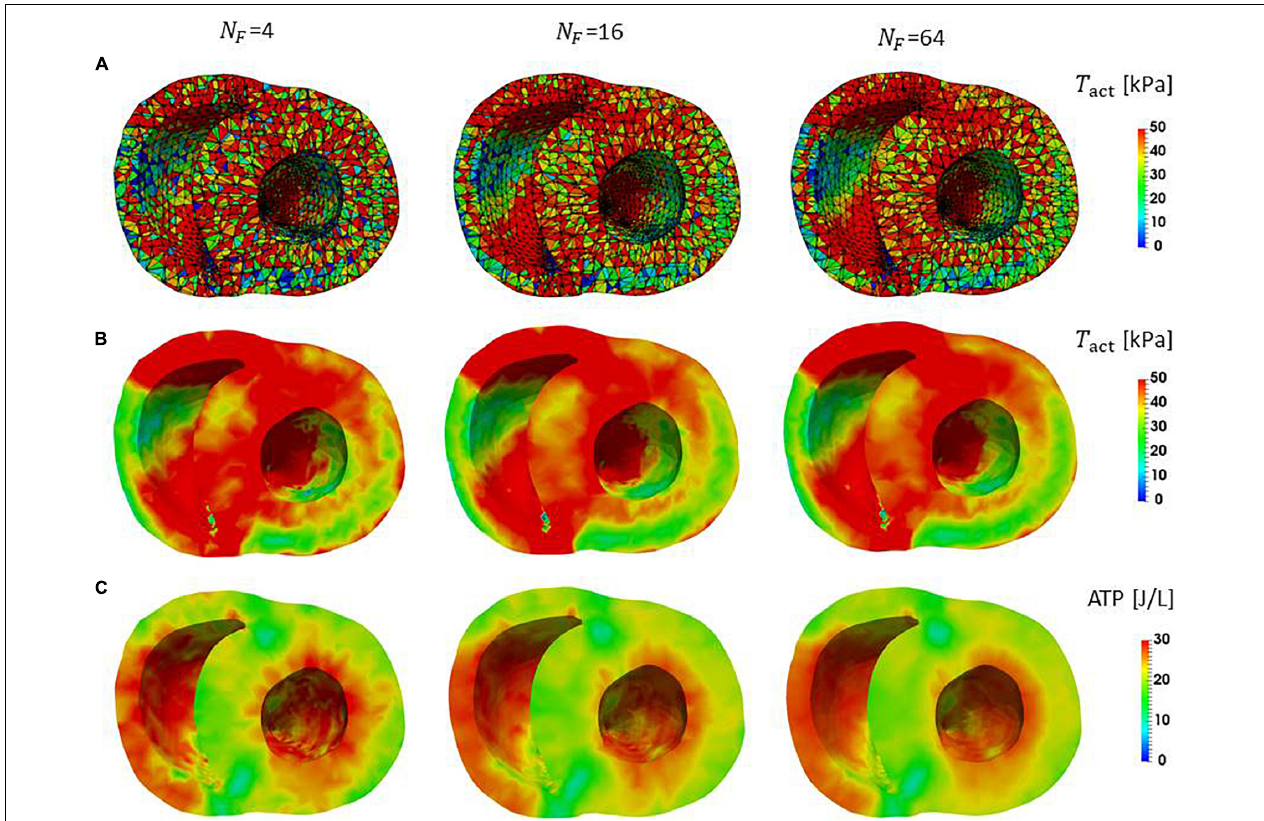
FIGURE 7 | Distributions of active tension and ATP consumption at T = 0.2 s in the contraction phase in the middle cross-section perpendicular to the long axis. (A) The active tensions calculated in the individual elements are shown. The lines indicate the segmentation to elements. The black lines are element boundaries. (B) The active tensions in elements were averaged on the nodes in the FE mesh. (C) The ATP consumption in the interval [0.0 s, 0.2 s] for the individual elements was averaged on the nodes in the FE mesh.